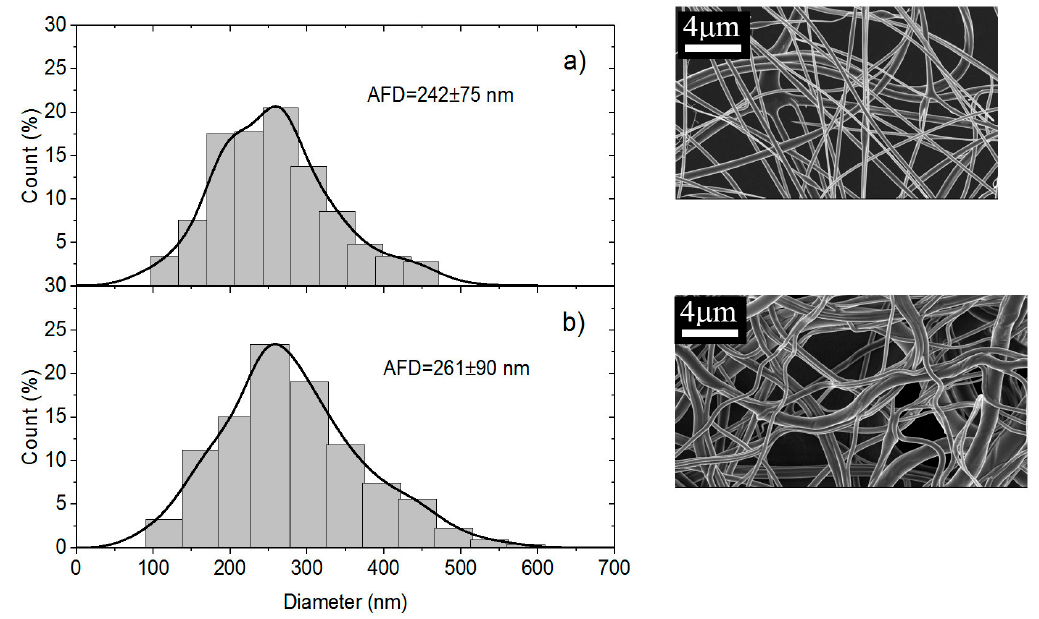
Figure 11. Diameter distribution of chitosan/PEO fibers expressed as a function of the count of fibers in % for PEO M W = 5 × 10 6 at the concentration of 5% ( a ) before washing and ( b ) after washing. Comparison of Figure 11a,b indicates that washing does not modify the fiber morphology.